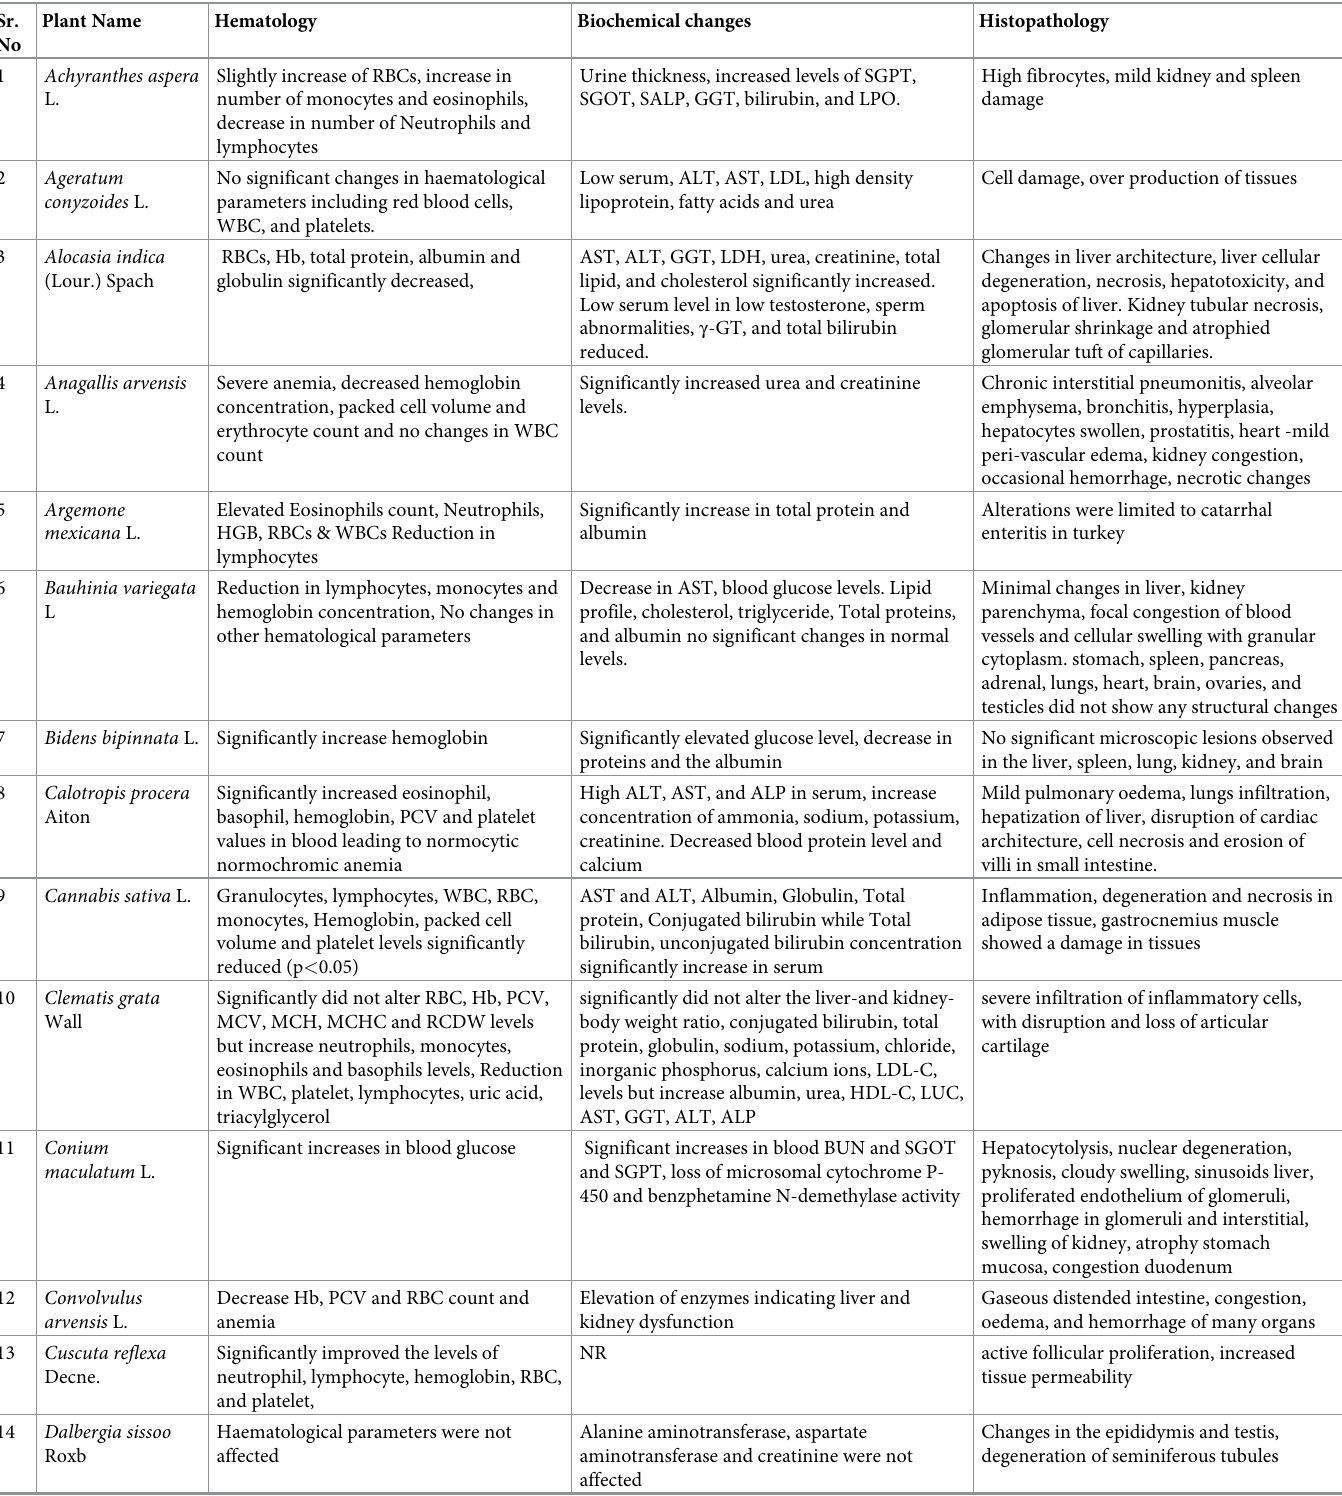
Table 5. Plant-based hematological, biochemical and histopathological observations in animals. Sr. Plant No